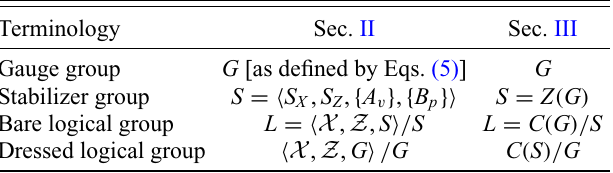
TABLE I. A summary of the stabilizer-subsystem-code con- cepts. This table collects the key concepts of subsystem codes—namely the gauge, stabilizer, and logical groups—and points out how these concepts are instantiated in Secs. II and III. Here, (cid:6)·(cid:3) denotes the multiplicative group generated by the enclosed set of operators and Z ( G ) and C ( G ) denote the center and centralizer, respectively, of the group G